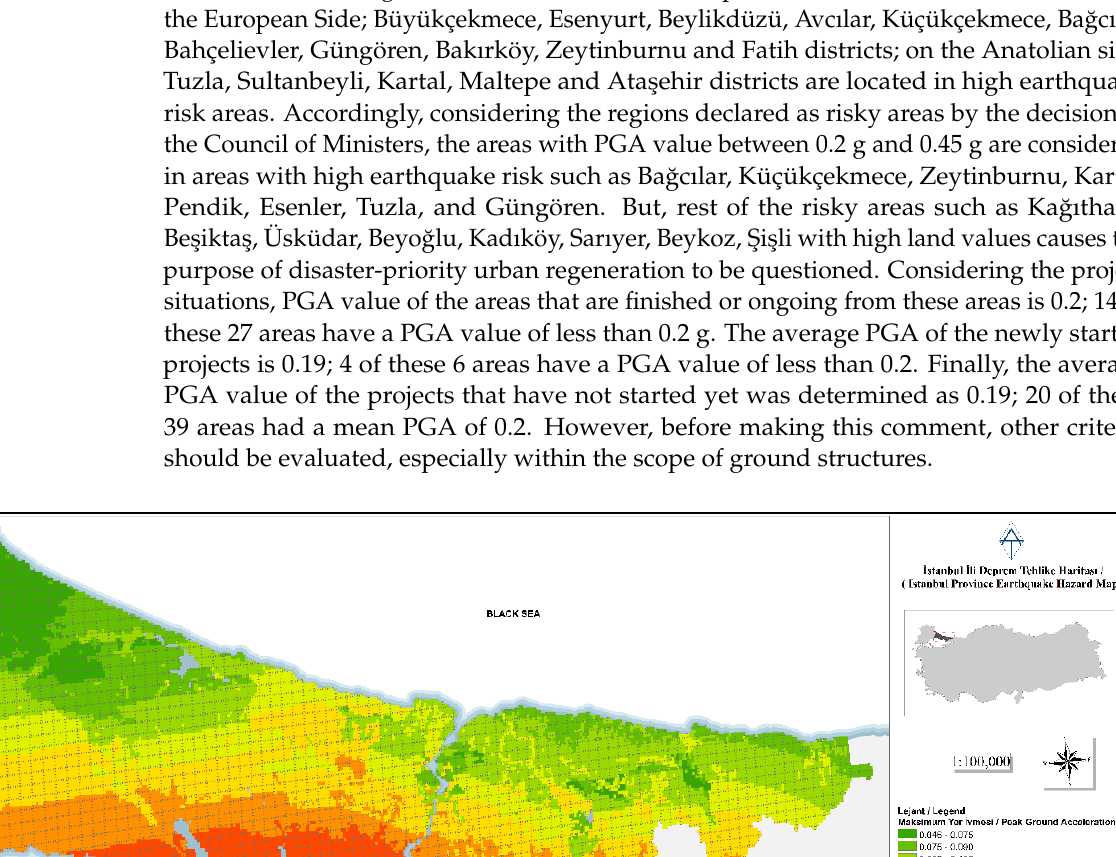
Figure 9. Istanbul Province Landslide Exposure Map (MTA, 2006 & IMM, 2007/2009). Considering that the active landslide zones describe the mass that is still in motion, as a result of analyzes carried out within the scope of the study, it has been determined that there are 6657 structures in the active landslide areas of the MTA and the high-risk